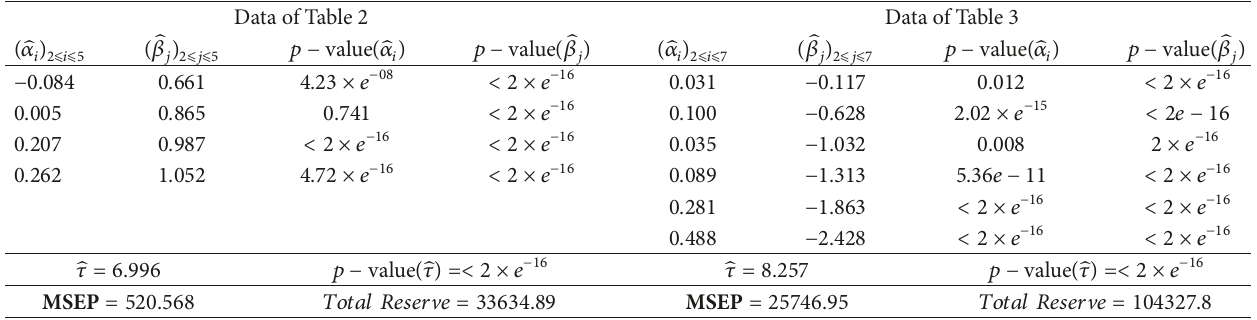
Table 4: Estimated parameters of model (equation (53)).